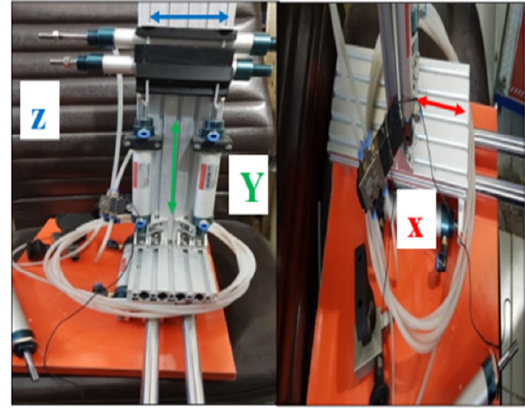
Fig.4: Layout of 3-axis pneumatic pick and place system.